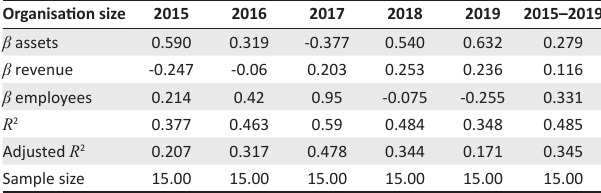
TABLE 2: Multiple regression – Organisation size on chief executive officers’ variable remuneration.